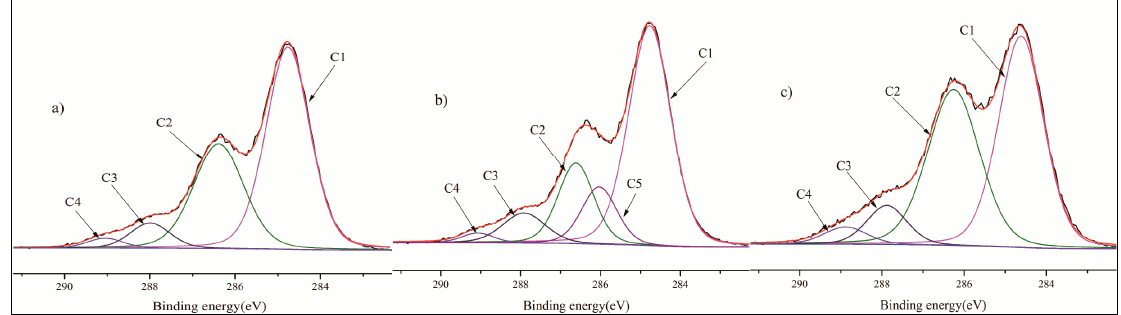
Figure 3. X-ray photoelectron spectroscopy (XPS) of thermo-treated cherry wood: ( a ) untreated, ( b ) nitrogen plasma treated and ( c ) oxygen plasma treated.